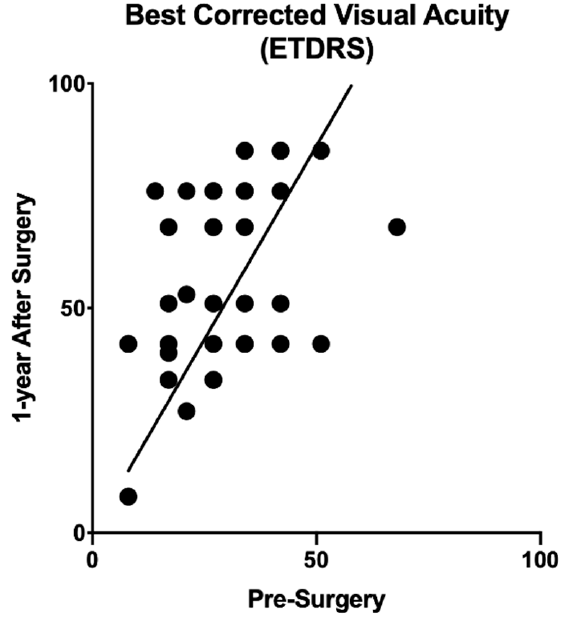
Figure 5. Scatterplot of visual acuity result obtained at 1-year follow up as a function of corresponding result at baseline. Solid line indicates equivalence of the values before and after surgery. Data points to the left of the equivalence line indicate improvements. Data on the right, decline. Improvements can be found in the majority of the eyes. Table 2. Distribution of 1-year visual acuity score in the two image clusters for the different CNN types. * p < 0.05; ** p <